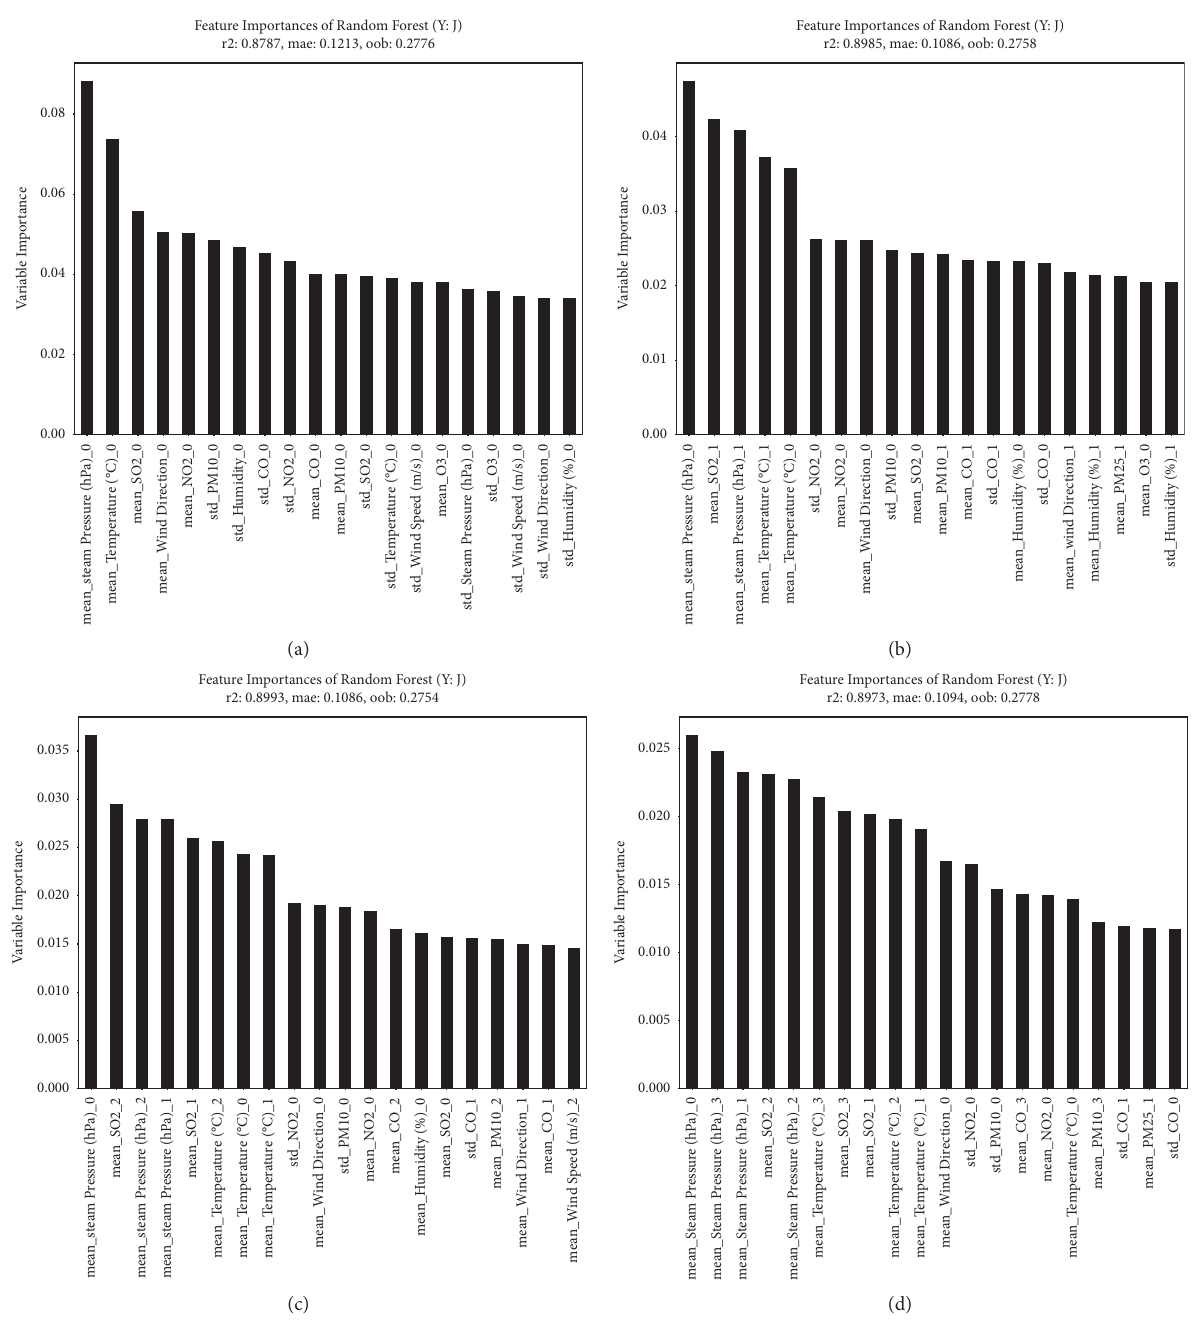
Figure 6: Analysis of the correlation between total respiratory disease patients’ visit to the ED and air pollution and weather variables: (a) day 0, (b) days 0–1, (c) days 0–2, and (d) days